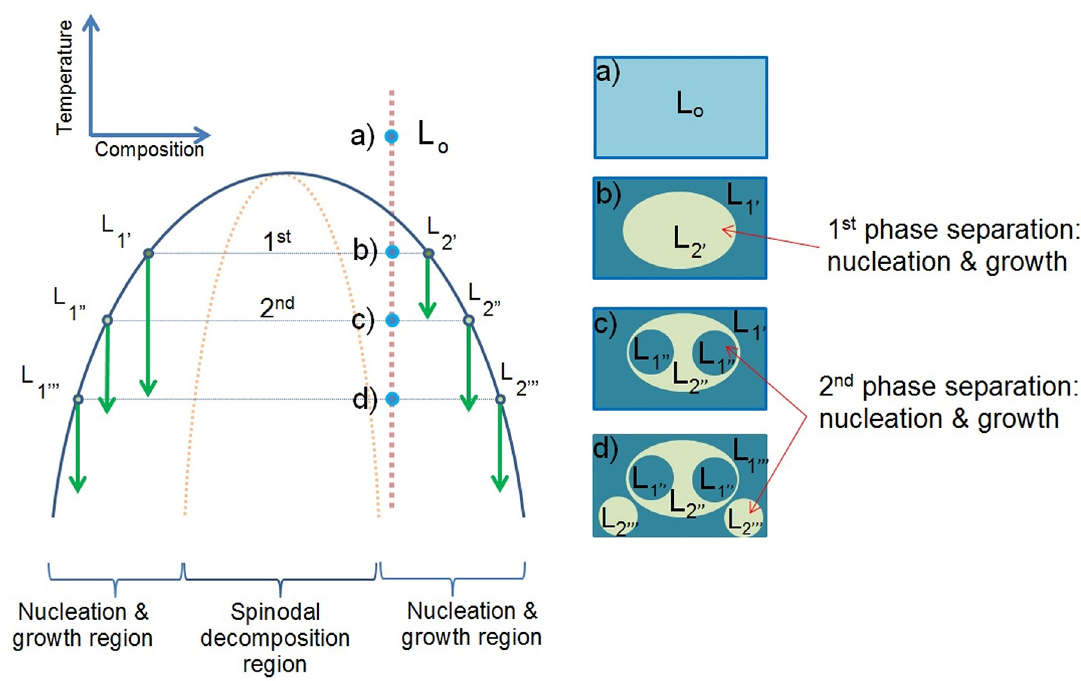
Figure 5. Schematic diagram showing multi-step phase separation sequence and marble structure